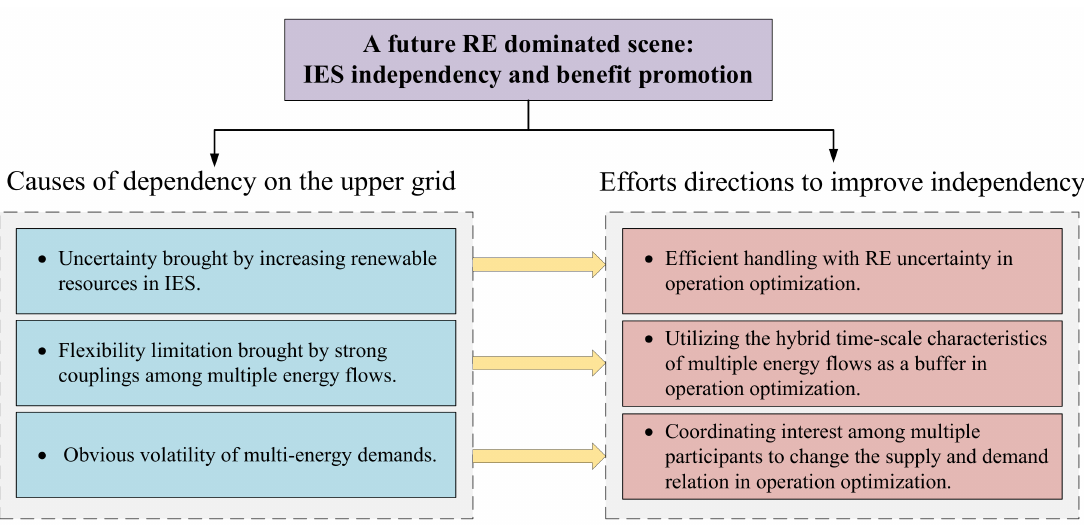
Figure 1. The illustration of efforts directions in IES independence